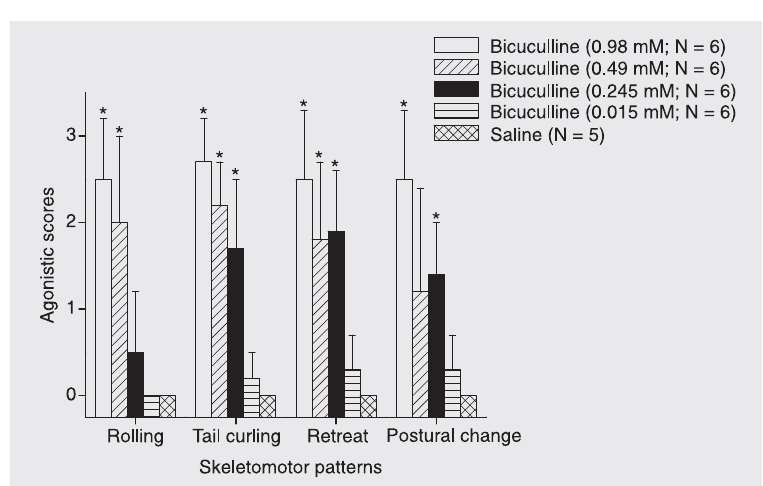
Figure 4. Intensity scores of skeletomotor patterns evaluated over a period of 2, 4 min after microinjection of different concentrations of bicuculline or saline into the torus semicircularis dorsalis of Gymnotus carapo . *P < 0.05 compared to the saline group (unpaired t- test)